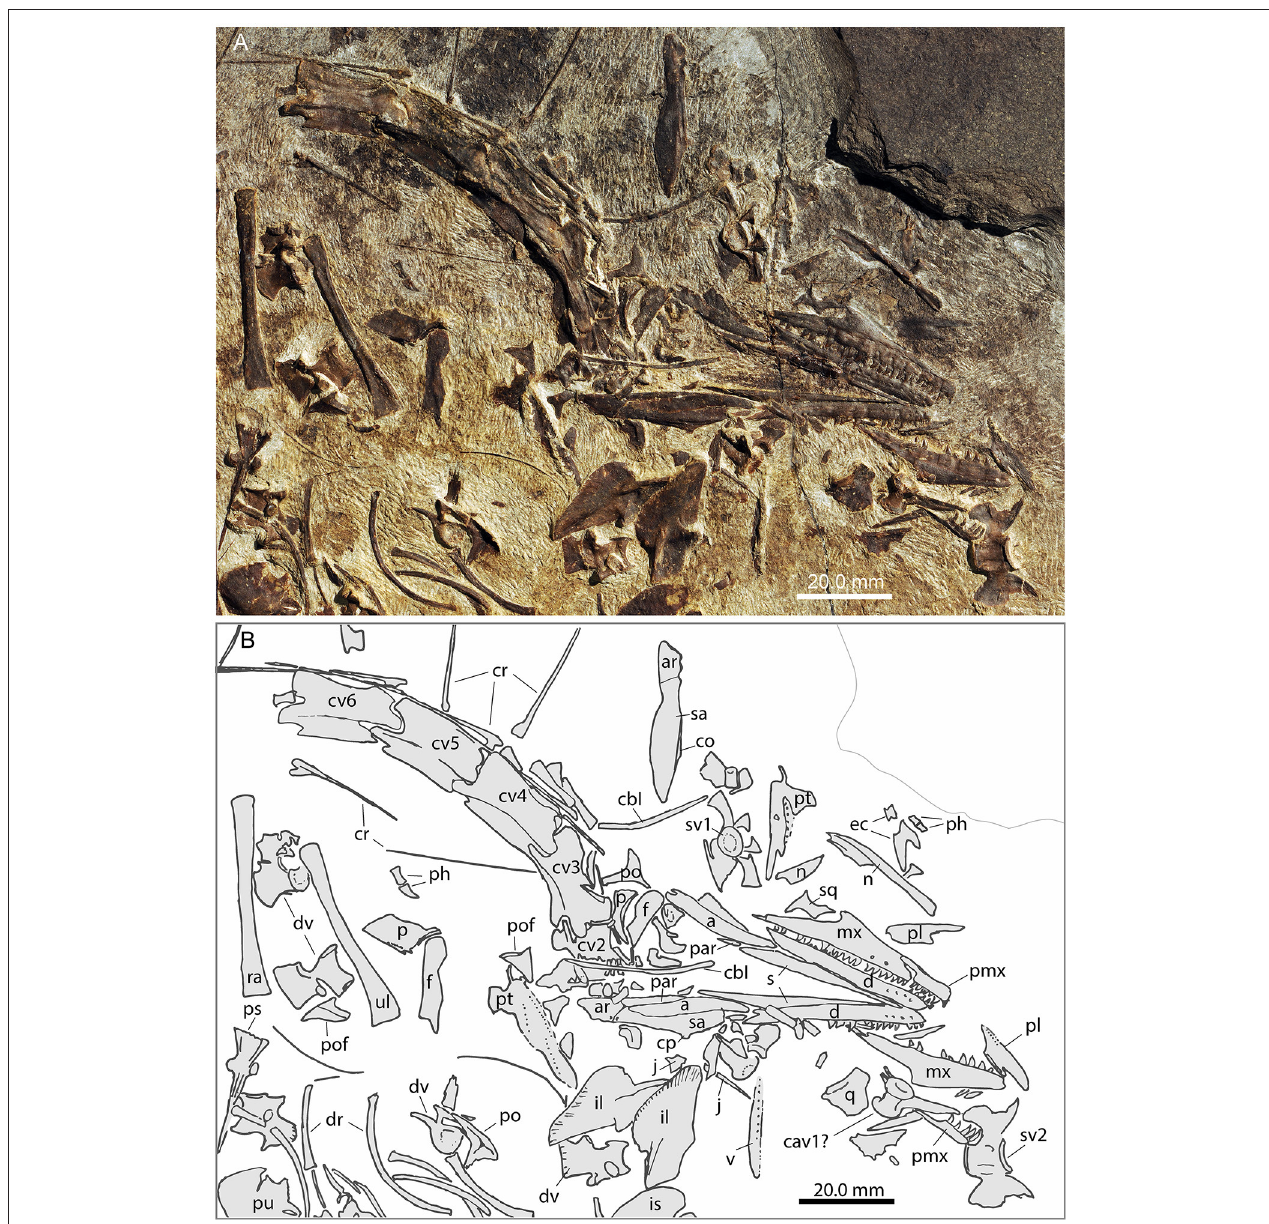
FIGURE 2 | Focus on the head region of PIMUZ T 1559. (A) Photograph; (B) interpretative drawing.